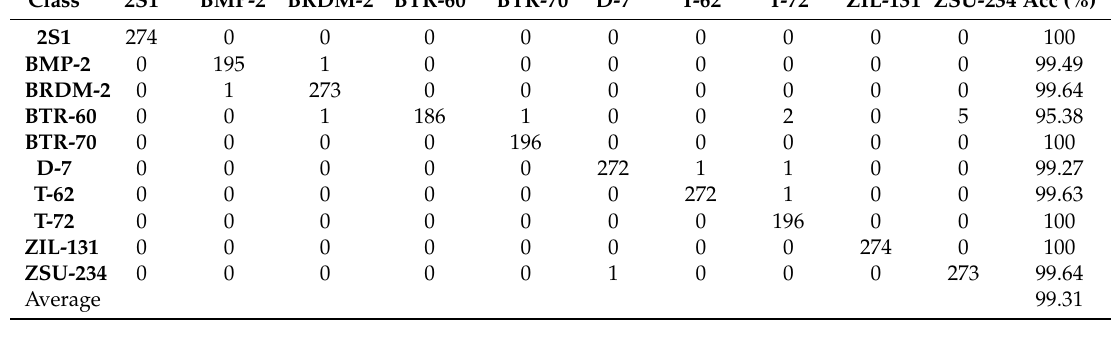
Table 2. The confusion matrix under SOC based on the proposed method.